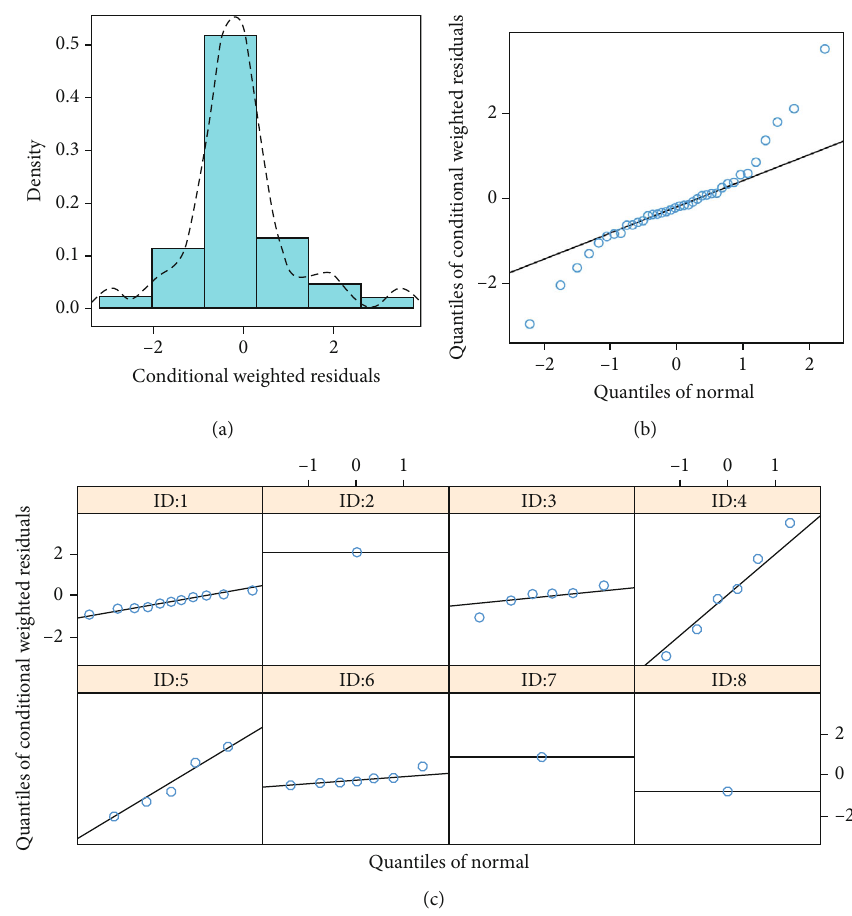
Figure 3: Distribution of conditional weighted residuals for model. (a) Density vs. conditional weighted residuals (CWRES), (b) quantiles of CWRES vs. quantiles of normal, and (c) quantiles of CWRES vs. quantiles of normal for individual. ID: 1-8 were from studies [16 –